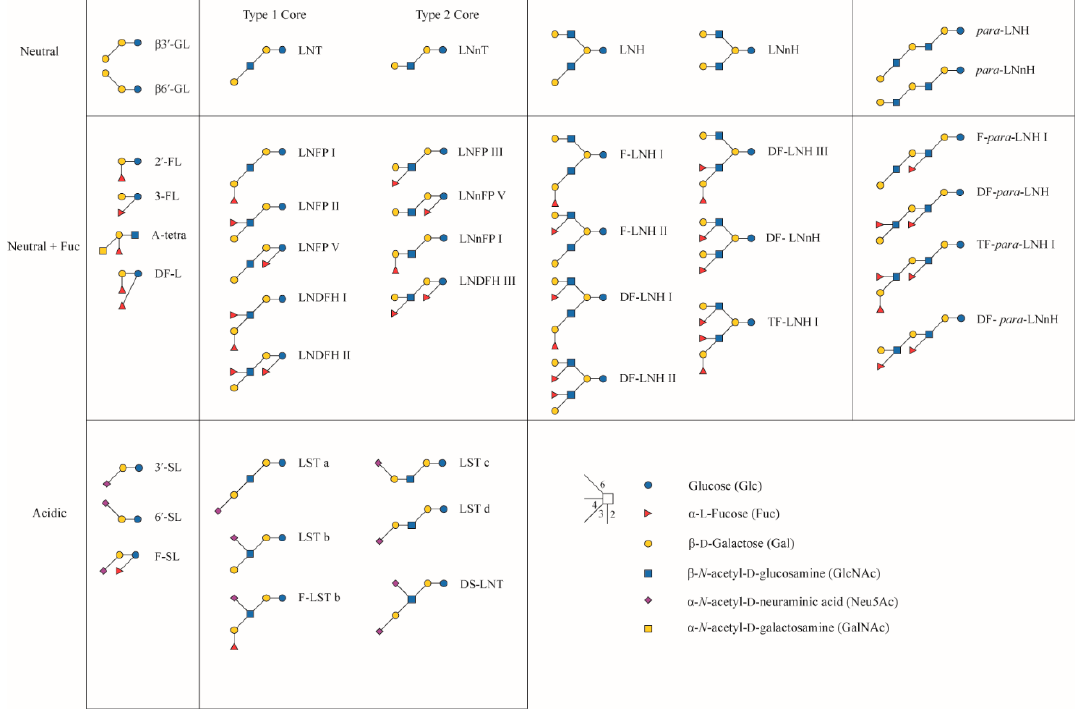
Figure 1. Overview of main human milk oligosaccharides (hMOS) structures for which quantitative data are available. Structures are drawn in the Consortium for Functional Glycomics graphical notation, and a legend for the structural elements is added